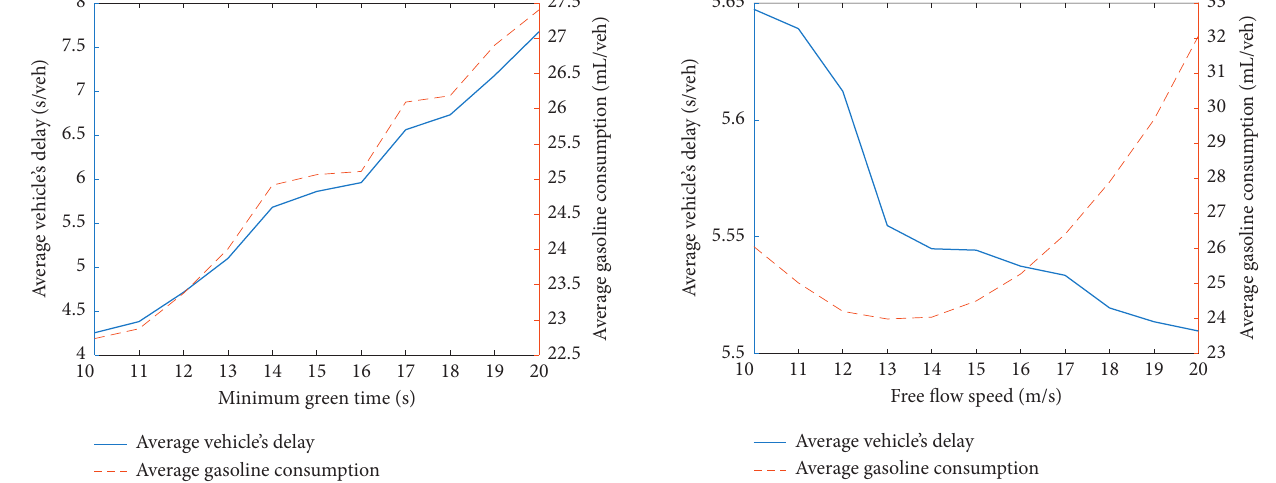
Figure 4: Sensitivity analysis on minimum green time. Figure 5: Sensitivity analysis on free-flow speed.